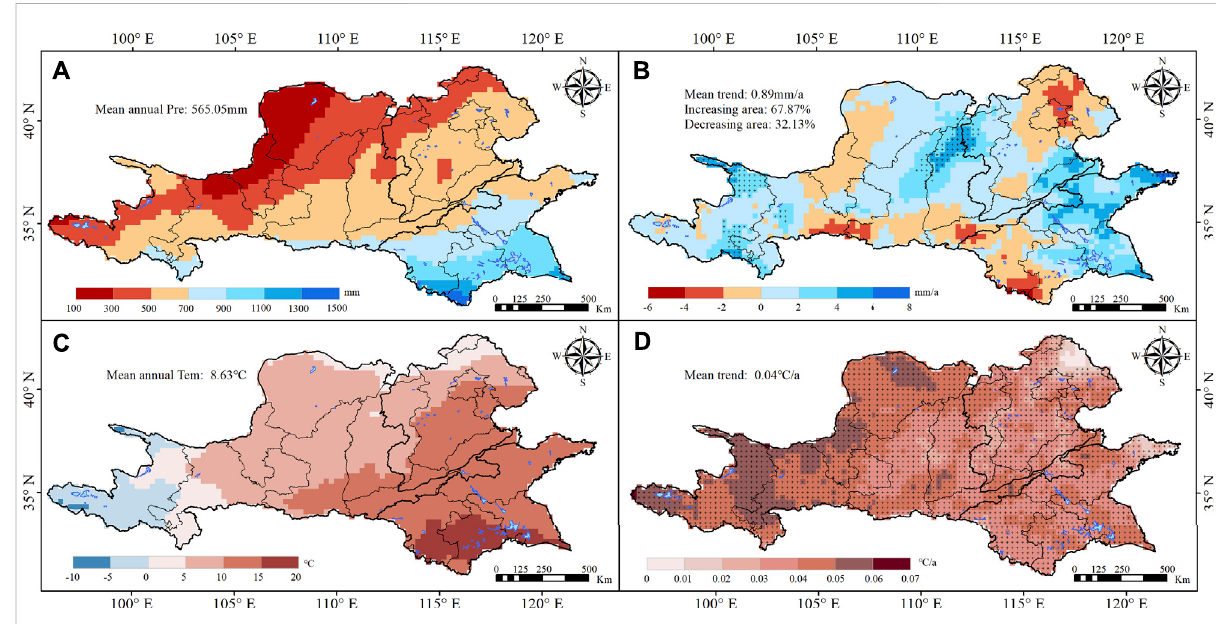
FIGURE 5 Spatial distributions of the annual mean precipitation (A) , temperature (C) , and their trends (B,D) in the YHHRB from 1982 to 2015. Regions labeled with “ + ” in (B) and (D) represent the trends are signi fi cant ( p < 0.05).